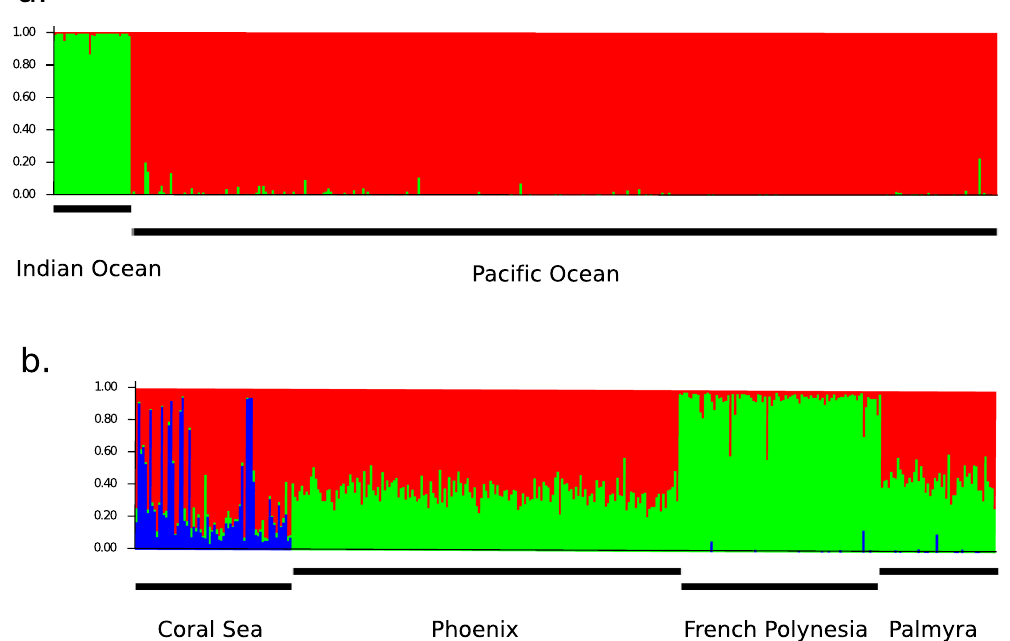
Figure 3. Bayesian Structure plots showing the most likely number of clusters (K) partitioning the dataset when including ( a ) all 407 specimens from the Indian and the Pacific Ocean, K = 2; and ( b ) the Pacific specimens only, K = 3. The most likely number of clusters were determined using the Evanno’s method (Evanno et al .